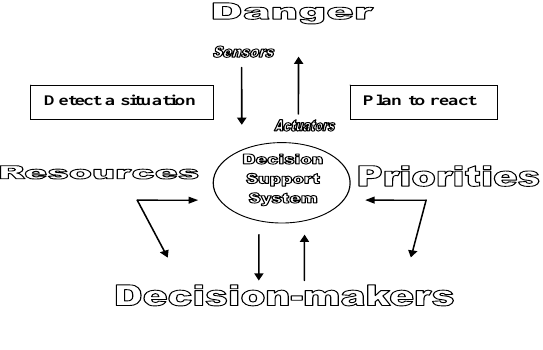
Fig. 1. General mixed-initiative